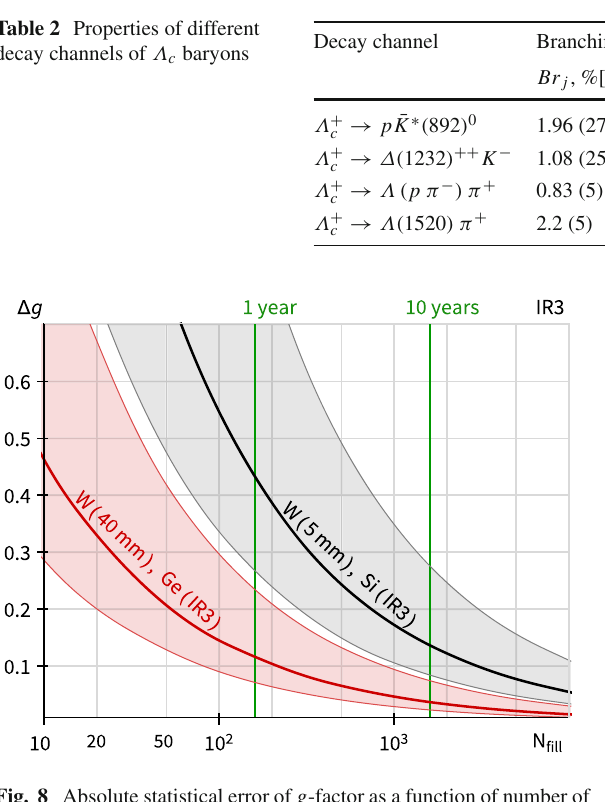
tungsten target attached to germanium crystal. Margins represents the current uncertainly of the weak decay parameters and the initial polar-